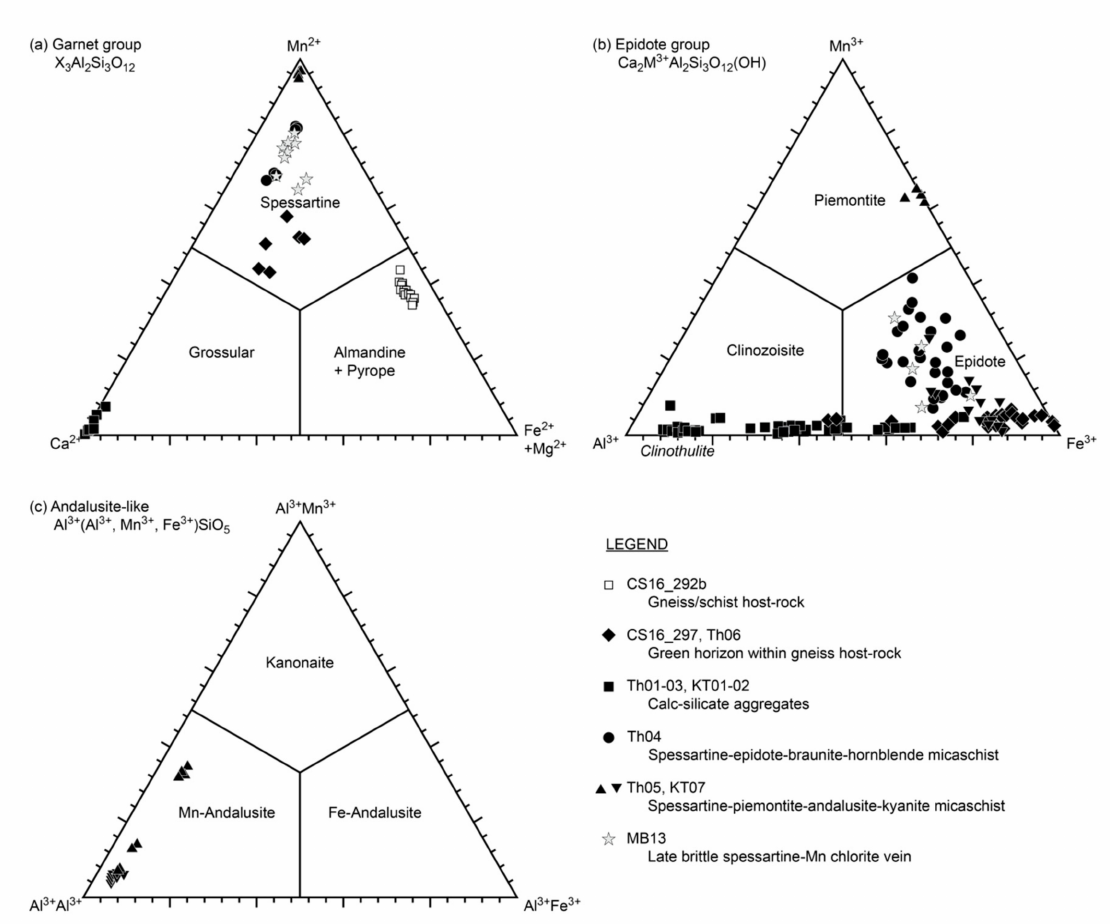
Figure 7. Ternary plots showing compositions of the garnet, epidote and andalusite group minerals. ( a ) Garnet composition considering spessartine, grossular and almandine + pyrope end-members. Garnet composition is X 3 Al 2 Si 3 O 12 with the X site occupied by divalent cations, Mn 2 + for spessartine, Ca 2 + for grossular, Fe 2 + for almandine and Mg 2 + for pyrope, e.g., [65]. ( b ) Epidote group minerals, Ca 2 M 3 + Al 2 Si 3 O 12 (OH), classified according to one M 3 + cation substitution with Al in octahedral coordination with M 3 + = Al 3 + , Mn 3 + or Fe 3 + , corresponding to the clinozoisite, piemontite and epidote end-members, respectively [66,67]. Composition analyses for deep pink to red clinozoisite (clinothulite) are shown. ( c ) Andalusite-like minerals, Al 3 + (Al 3 + Mn 3 + Fe 3 + )SiO 5 , classified according to octahedral Al substitution with Mn 3 + or Fe 3 +